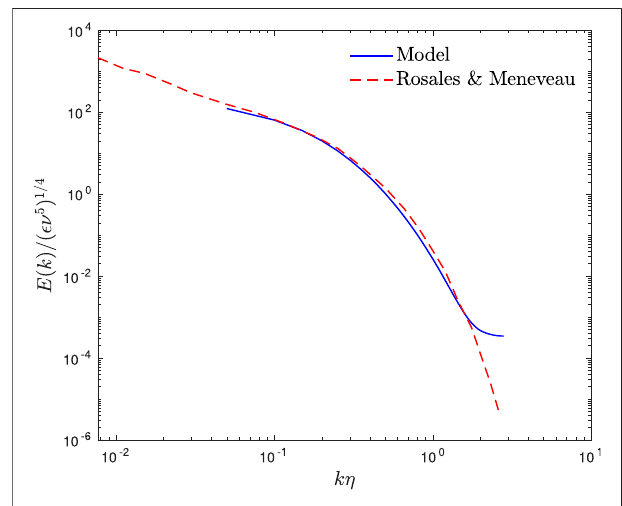
FIGURE 1 | Model validation with DNS simulation results from Rosales and Meneveau